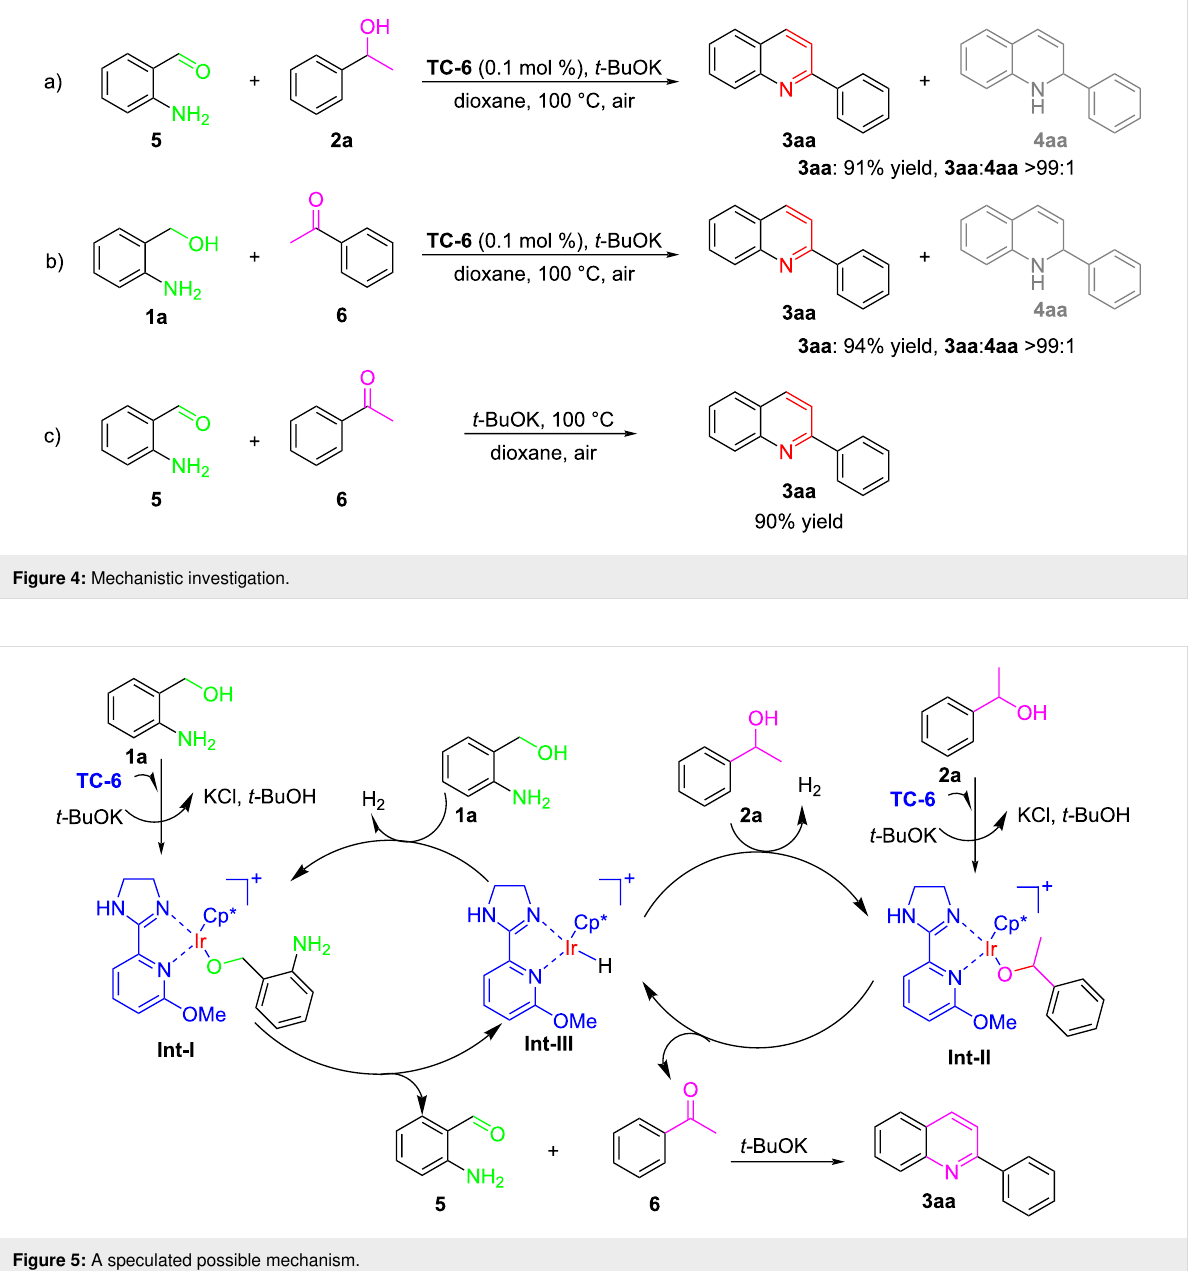
was obtained by the condensation and cyclization of the alde- hyde 5 with acetophenone ( 6 ) under base